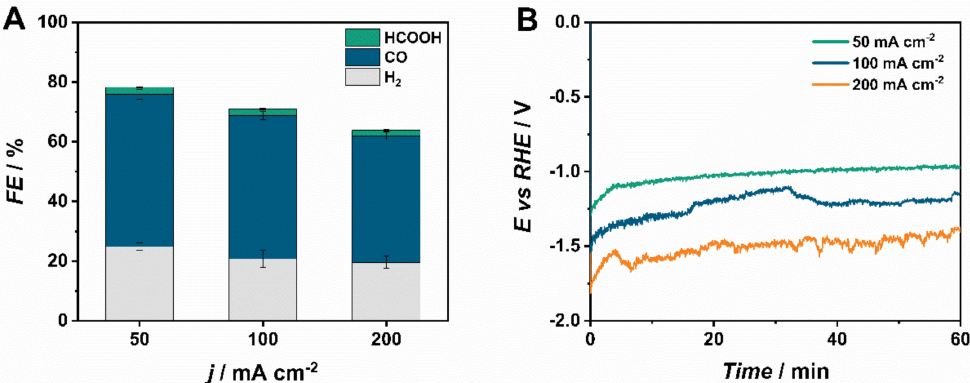
Figure 5. Performance of Ag(I) bis-BIAN complex Ag4 on H23C6 carbon paper GDL during the het- erogeneous electrocatalytic CO 2 reduction process. ( A ) Faradaic efficiencies after 1 h of galvanostatic electrolysis at different current densities in 1M KHCO 3 . ( B ) Obtained potential curves of galvanostatic electrolysis at different current densities in 1M KHCO 3